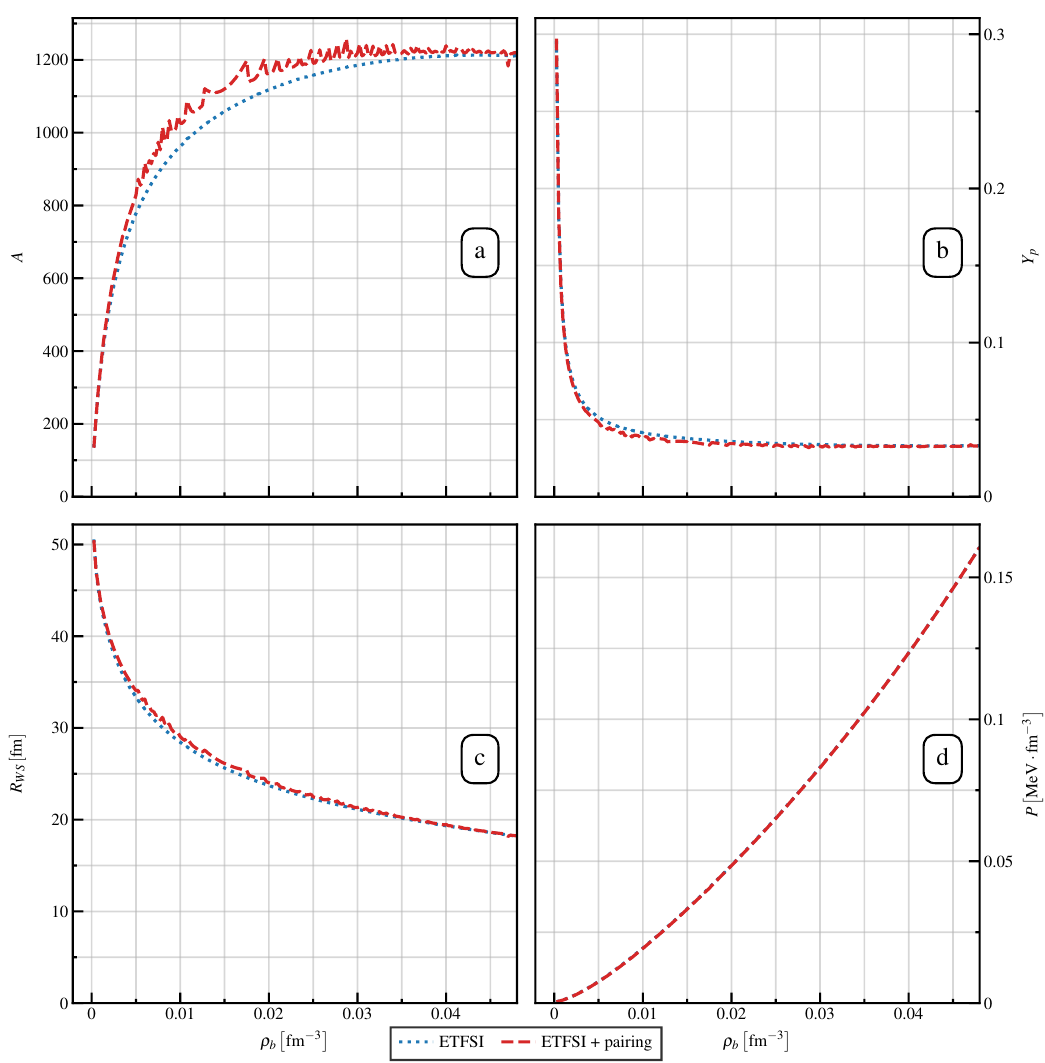
Figure 7. The variation through the inner crust of: the total particle number A (panel a ), proton fraction Y p (panel b ), Wigner–Seitz cell radius R WS (panel c ) and pressure P (panel d ). ETFSI results are shown with blue dotted lines, and those for ETFSI+pairing are shown with red dashed